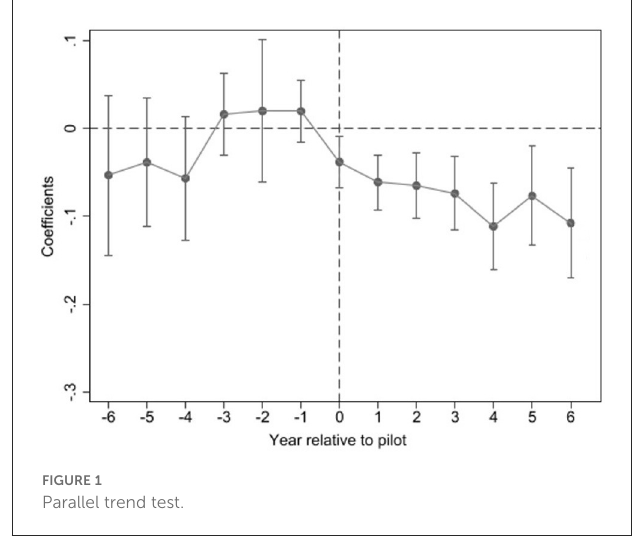
TABLE 3 Benchmark regression results.